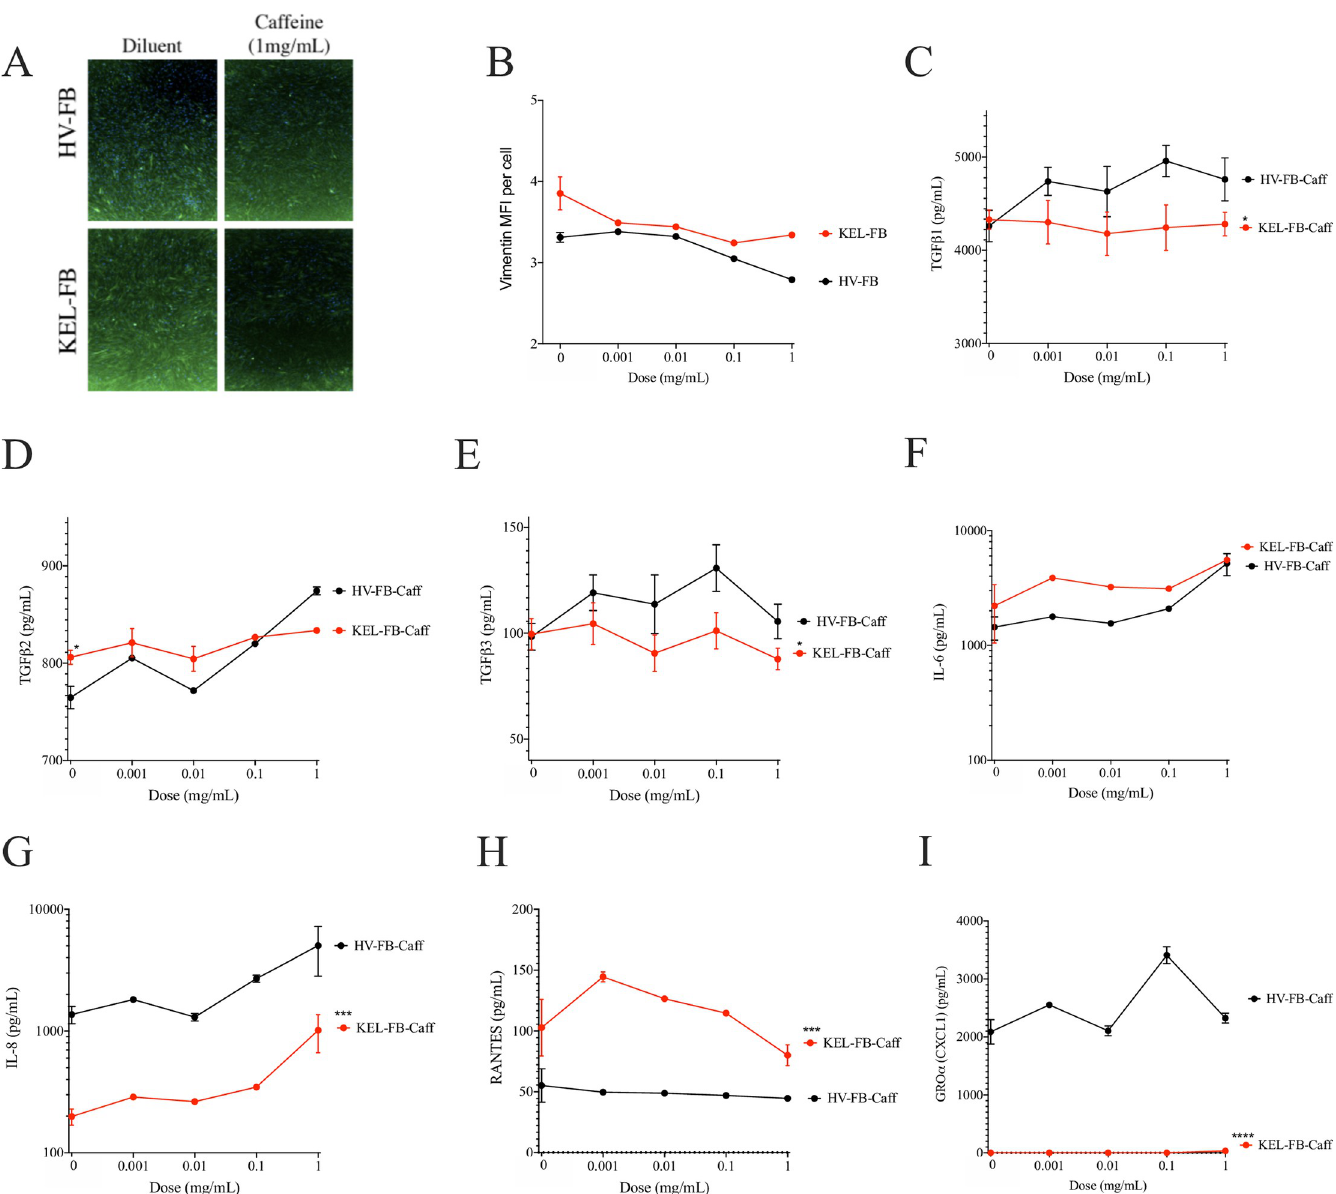
Fig 3. Impact of caffeine on vimentin expression and cytokine production. (A) Representative images from vimentin stain in healthy volunteer (HV-) or keloid- derived (KEL-) fibroblast cell lines (FB). (B) Mean fluorescence intensity (MFI) per cell for vimentin for HV-FB and KEL-FB treated with indicated doses of caffeine. (C-I) Supernatant accumulation of cytokines and chemokines for cells treated with caffeine. Transforming growth factor beta 1 (TGF β 1; C), TGF β 2 (D), TGF β 3 (E), interleukin (IL-) 6 (F), IL-8 (G), RANTES (H), and CXCL1/GRO α (I) are shown. Results are representative of two independent experiments and displayed as mean + SEM for triplicate wells. � = p < 0.05; ��� = p < 0.001; for statistical comparison of area under the curve versus HV-FB under diluent stimulation conditions as determined by ANOVA with Sidak